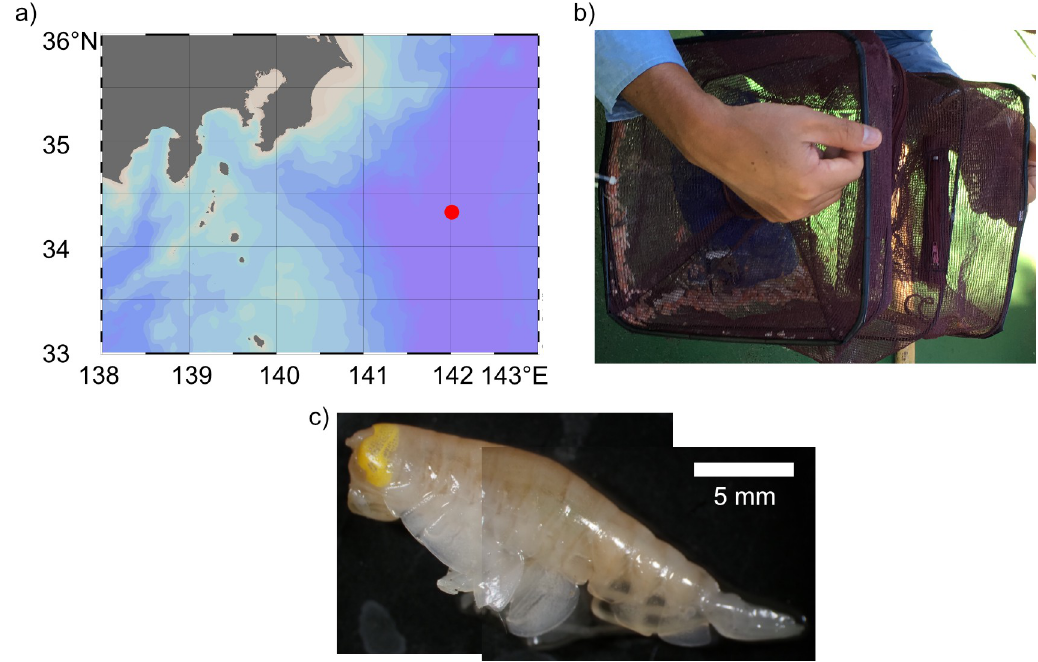
Fig 1. Sampling of Hirondellea gigas . a) Sampling location represented by the red dot. b) H . gigas collected in the bait trap. More than 200 individuals were collected. c) A micrographic montage of H . gigas under stereomicroscopy.